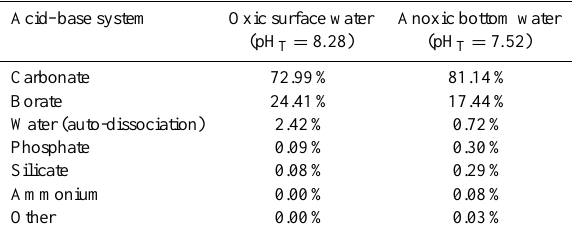
Table 2. Contributions of various acid–base systems to the acid– base buffering capacity β in August at 1 and 32m